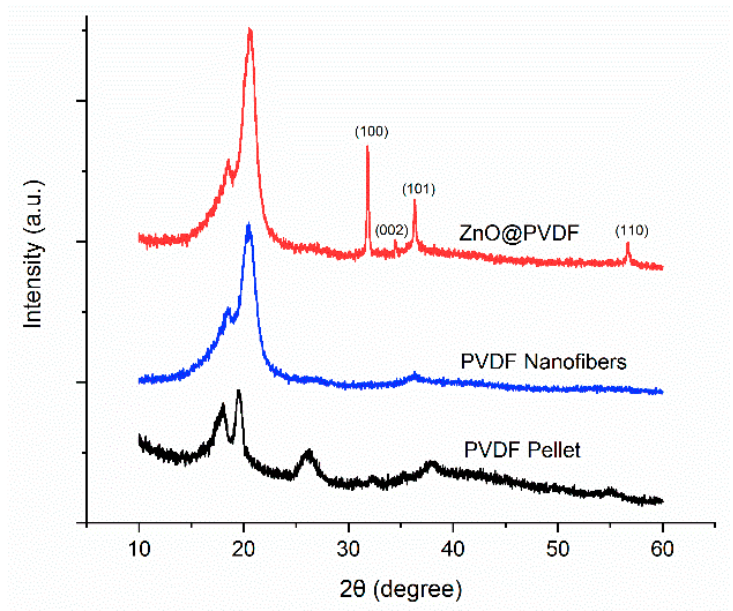
Figure 3. XRD spectra of the PVDF pellet, PVDF membrane, and ZnO@PVDF. Polymers 2018 , 10 , x FOR PEER REVIEW